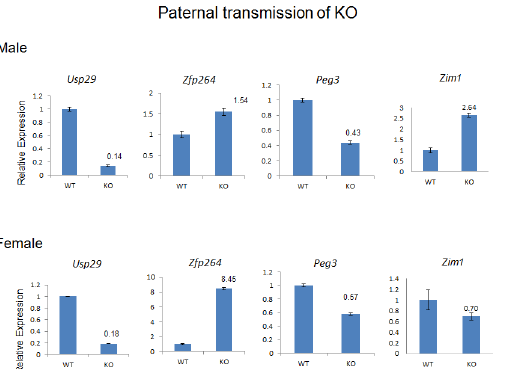
Fig 5. Mutational effects on transcriptional levels. A series of qRT-PCR were performed to test the mutational effects of the knockin allele on the transcriptional levels of the imprinted genes. The series of analyses used the total RNA isolated from the brain of the one-day-old pups carrying the knockin allele paternally. The expression levels of each gene were first compared between the wild-types and the heterozygotes, and the relative levels are presented in a graph with standard errors (S.E.). The expression levels of two genes, Usp29 and Zfp264 , were affected the most by the knockin